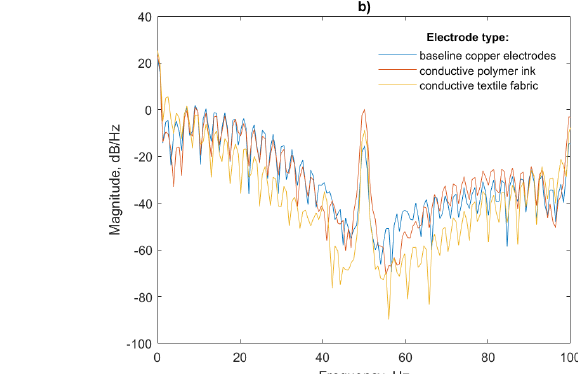
Figure 11. 5 s segments of a simulated ECG signal for ( a ) baseline copper electrodes; ( b ) conductive polymer ink; ( c ) con- ductive textile fabric.